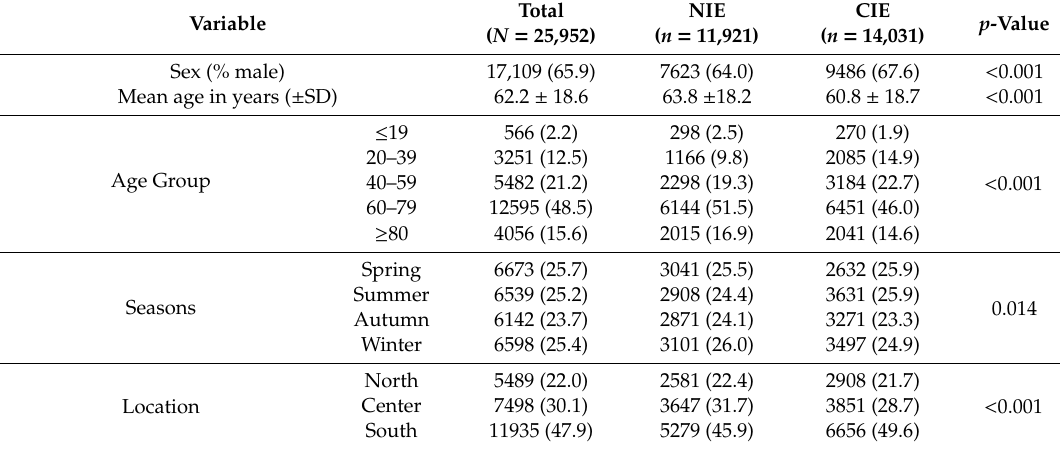
Table 2. Comparison between nosocomial infective endocarditis and community-acquired infective endocarditis in Spain from 1997 through 2014.